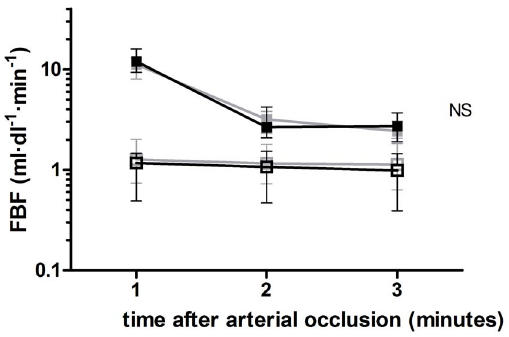
Figure 4. PORH after 2 minutes of arterial occlusion. PORH in the first 3 minutes after 2 minutes of arterial occlusion during placebo (grey) and eplerenone (black) treatment in the experimental (filled squares) and non-experimental (open squares) arm.